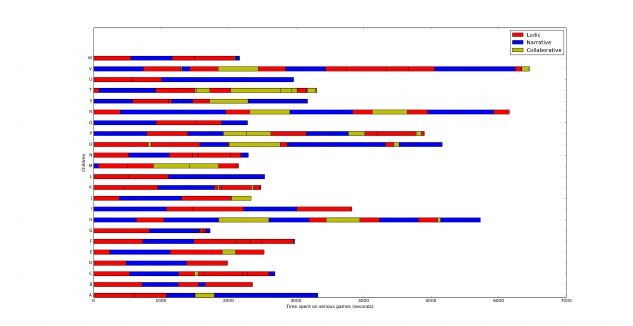
Figure 15. Visualization of game sessions over time for each